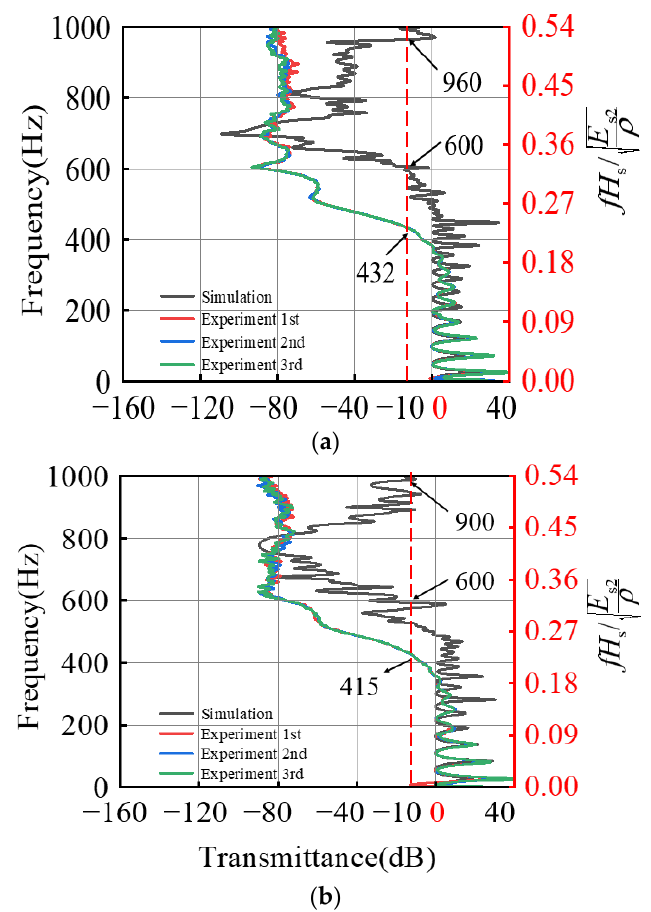
Figure 12. Vibration transmission characteristic curve: ( a ) the thickness ratio H f / H s of 7.0 × 10 − 2 and 5.0 × 10 − 2 ; ( b ) the modulus ratio E s1 / E s2 of 77.0 × 10 − 4 and 47.0 × 10 − 4 .